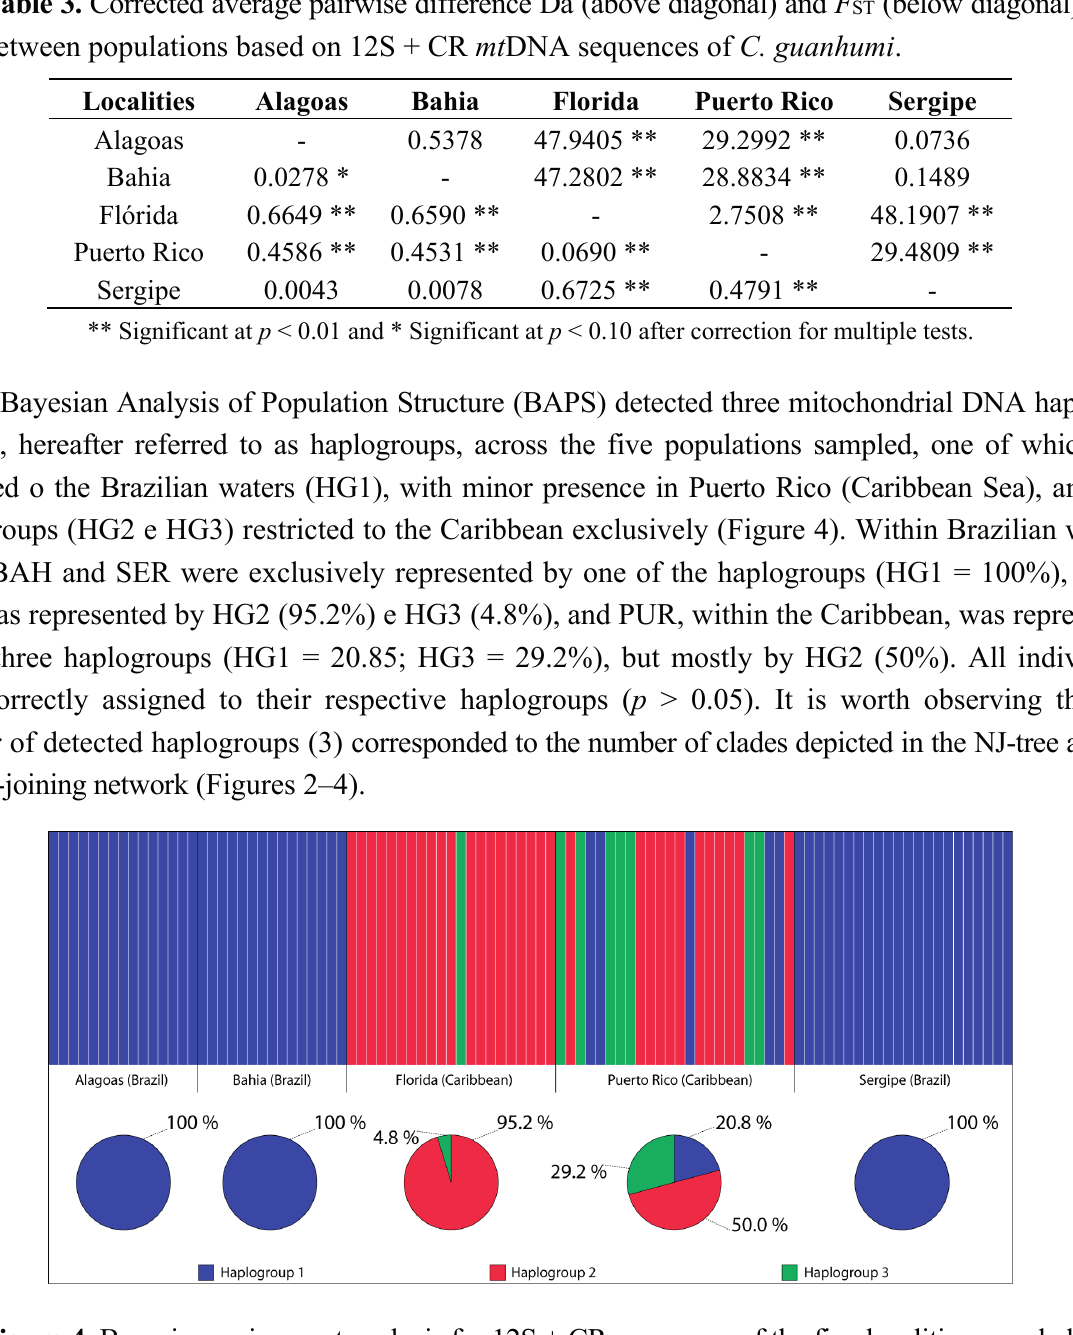
Figure 4. Bayesian assignment analysis for 12S + CR sequences of the five localities sampled. Each vertical bar represents an individual and its associated probability of belonging to one of the three haplogroups detected ( p =